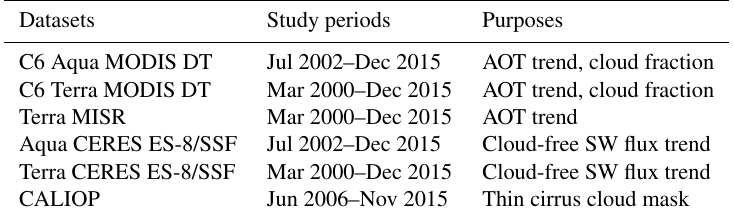
Table 1. List of datasets used in the